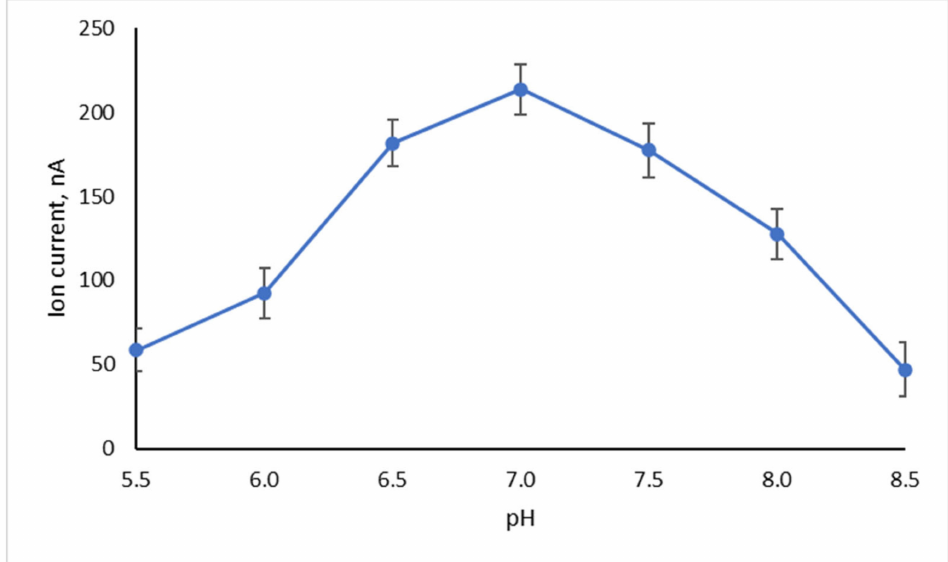
Figure 5. The effect of pH on the response of a metal-supported PC membrane incorporating 2.5 µ g/mL tyrosinase (0.1M KCl buffered with HEPES; 0.5 mm diameter Teflon-coated silver wire; 25 ◦ C) towards 3.72 pg/mL phenol (as concentration in bulk). Error bars denote standard deviation ( n = 5). For more details, see